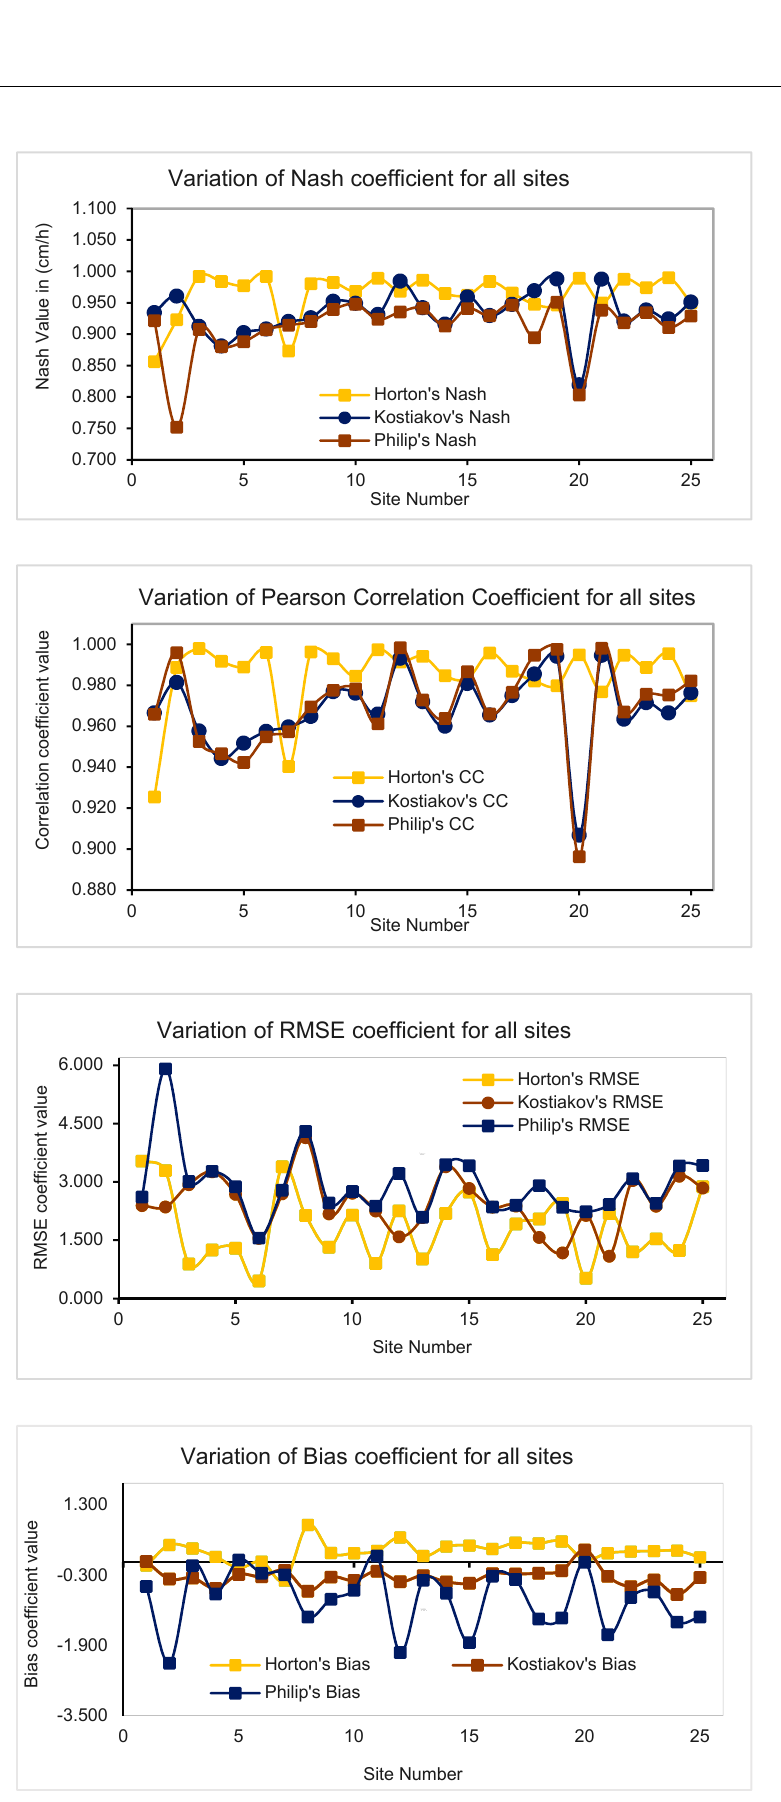
Figure 9. Validation of estimated parameters according to the variation of statistical measures.